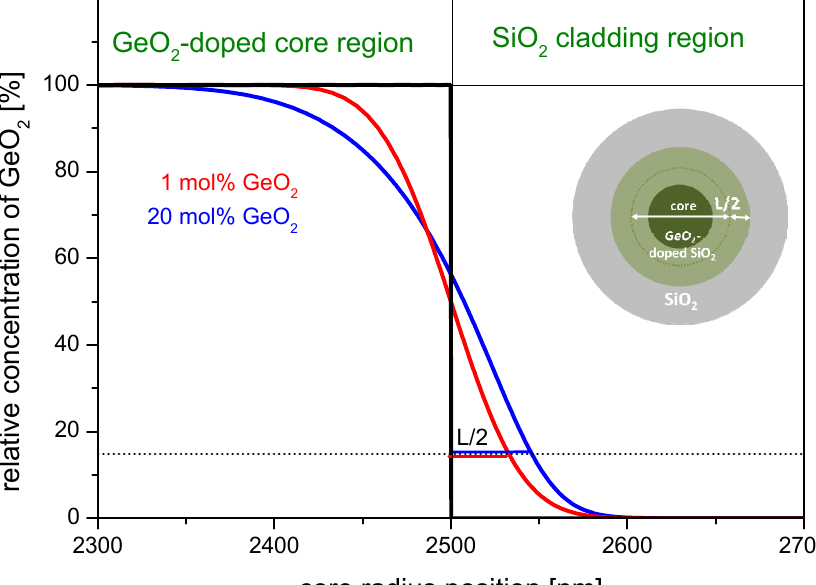
Figure 3. Simulated dopant concentration profiles due to diffusion in the boundary region for germanium doped step index cores with a starting diameter of 5 µm at a drawing temperature of T max = 1900 °C and one drawing pass (simulated for fiber geometry conditions). Black curve: assumed initial profile; red curve: simulated profile starting with 1 mol% GeO 2 ; and blue curve: simulated profile starting with 20 mol% GeO 2 . The inset figure shows a sketch of a GeO 2 -doped element, the dark green region represents the original concentration; and the light green represents the region with lower